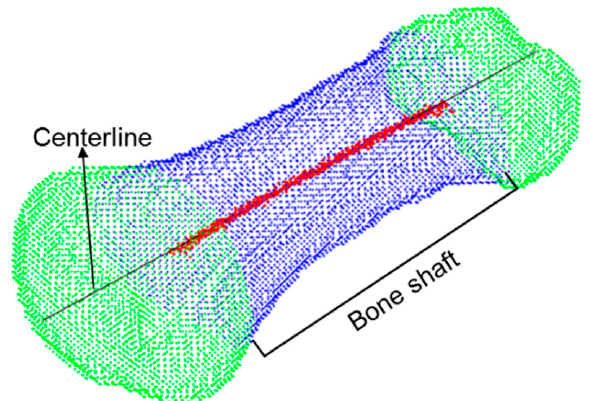
Figure 7. Identification of the centerline for the distal bone of a joint by performing a linear fit of the centroids (red) of the surface vertices at the perpendicular planes to a preliminary centerline along the distal bone shaft.